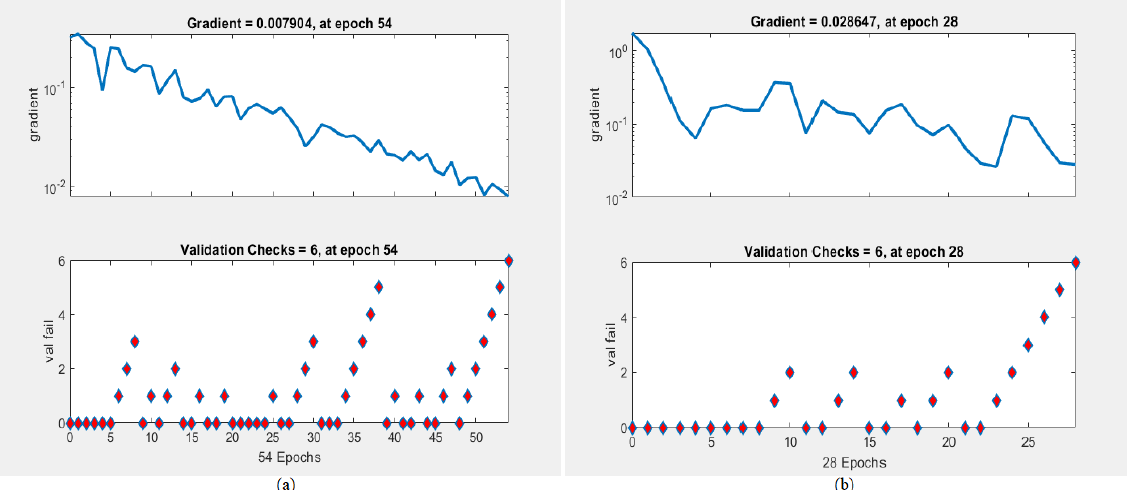
Figure 13. The training gradient displays of the ANN algorithm considering the datasets used. ( a ) The ISIC 2018 dataset. ( b ) The PH2